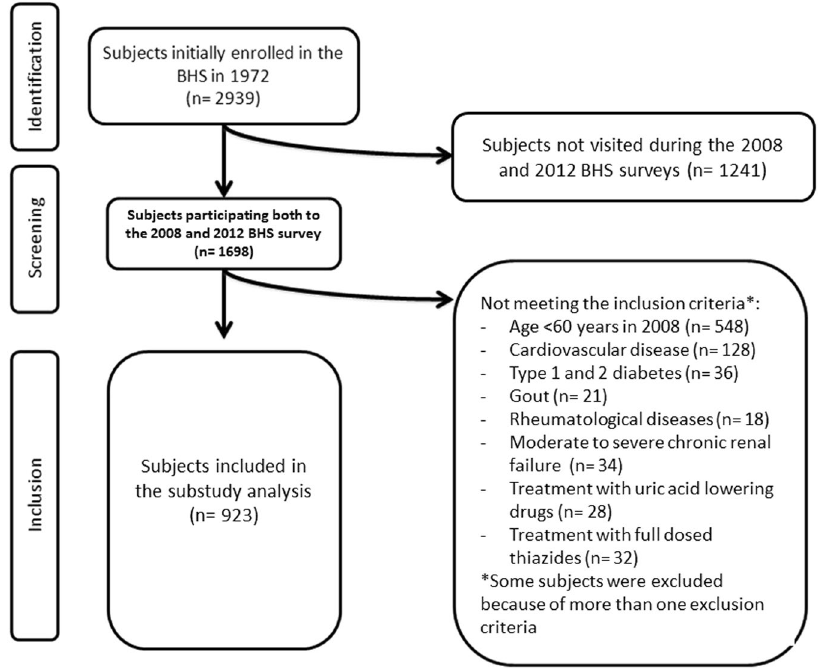
Figure 1. Flow-chart resuming the selection criteria applied to the full cohort to select the investigated